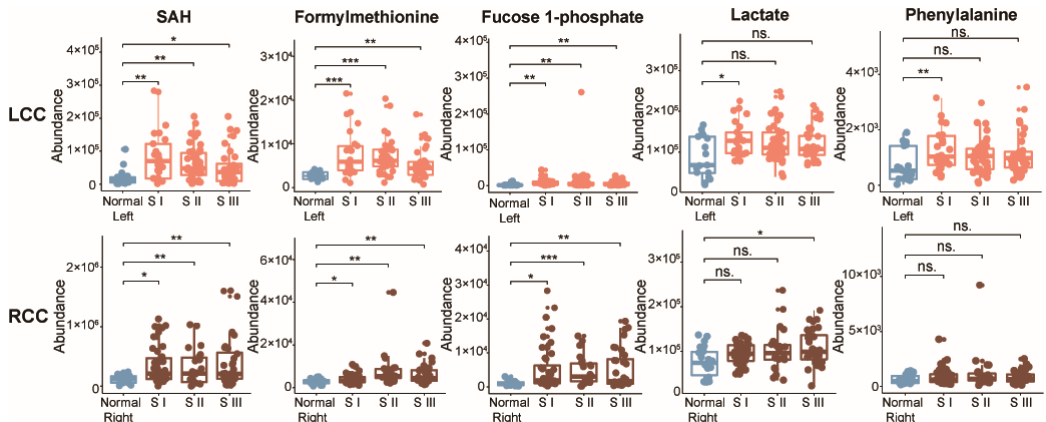
left-sided normal colon (Normal Left, n = 17), left-sided colon cancer (LCC, n = 25), right-sided normal colon (Normal Right, n = 22), and right-sided colon cancer (RCC, n = 22). Nonparametric Kruskal– Wallis rank sum test with pairwise Wilcoxon Mann–Whitney U test, p values adjusted for false discovery rates (FDR) (Benjamini–Hochberg). * p < 0.05, ** p < 0.01, *** p < 0.001, NS. = not significant. ( b ) ROC curve plot of predictive model, based on five metabolic biomarkers using random forest (RF), differentiating LCC from RCC.